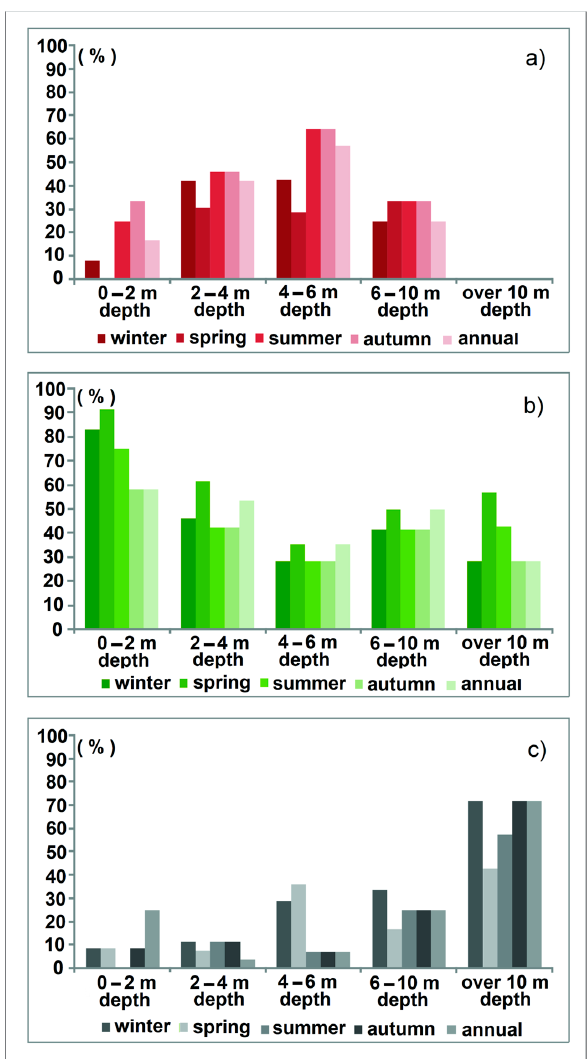
Figure 7. Frequency of positive ( a ), negative ( b ), and without statistical significance ( c ) of ITA index for different classes of groundwater level.